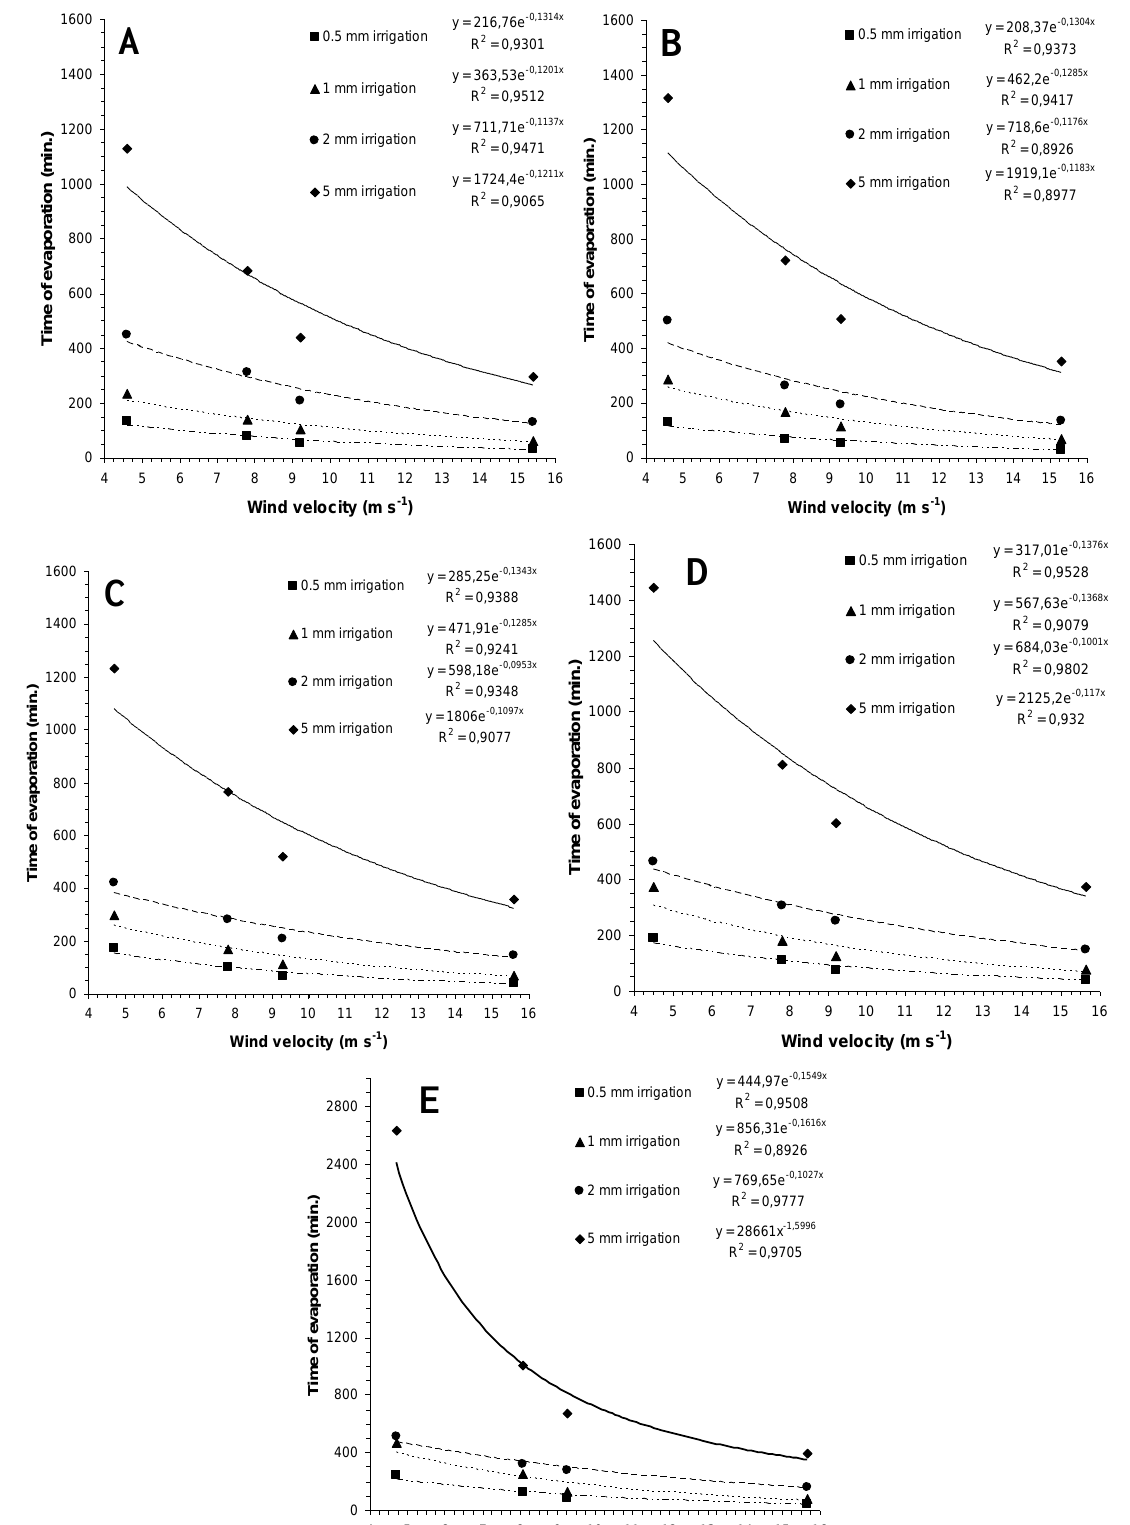
Figure 3. Functional relationships between the time of evaporation (min.) and wind velocity (m s −1 ) of 5 soil texture categories (( A ): sand, ( B ): loamy sand, ( C ): sandy loam, ( D ): loam, and ( E ): silty loam). Commas in the equations and R 2 represent decimal points.